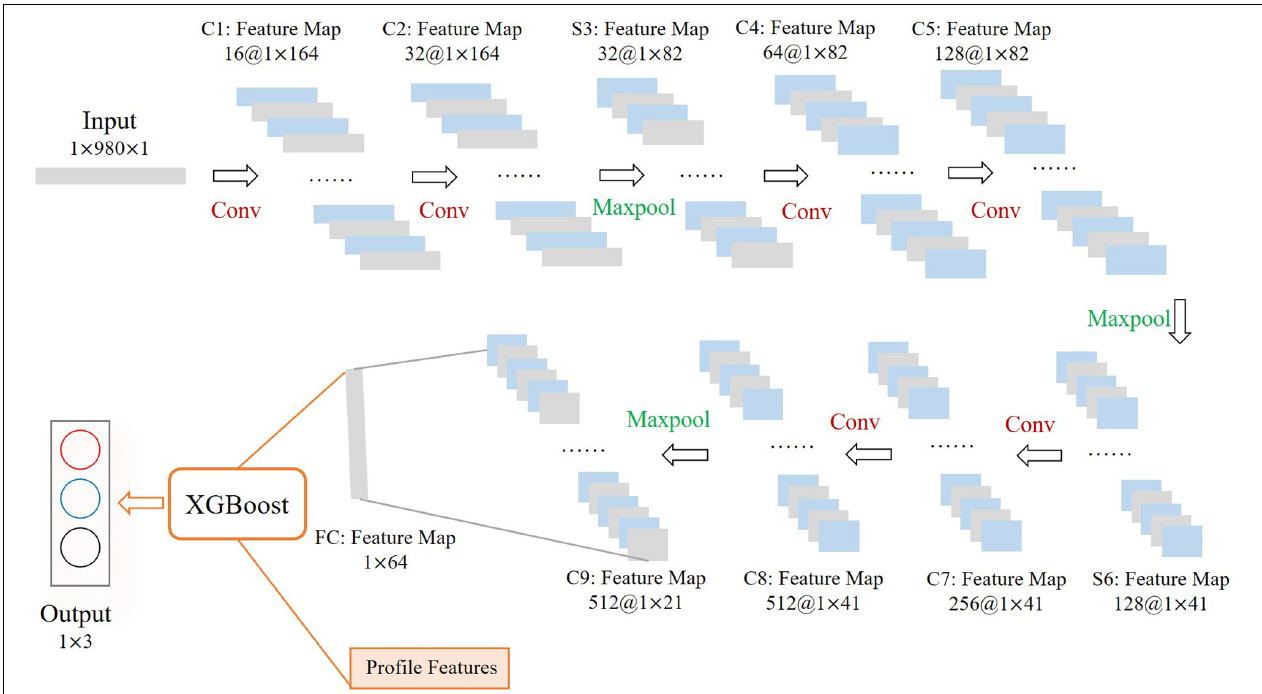
FIGURE 2 | Convolutional neural network with extreme gradient boosting (CNN-XGBoost)